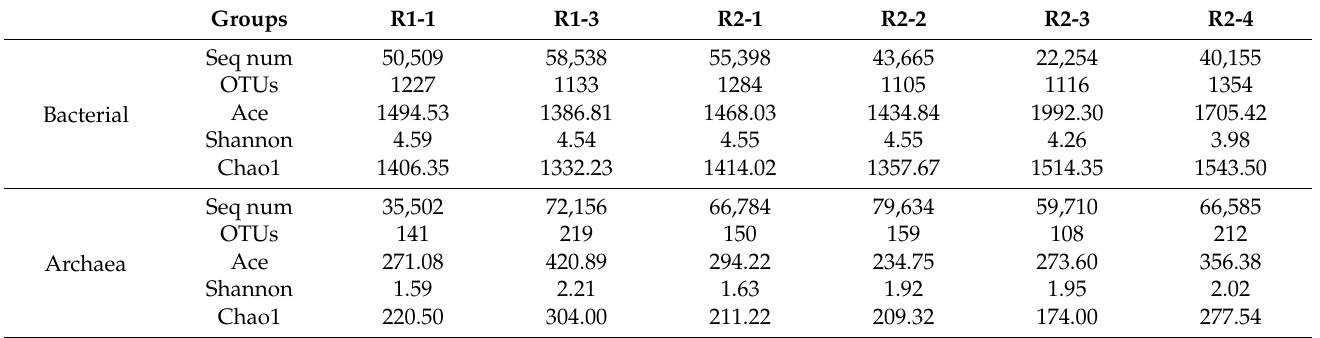
Table 3. Alpha diversity parameters of the microbial community during the anaerobic digestion